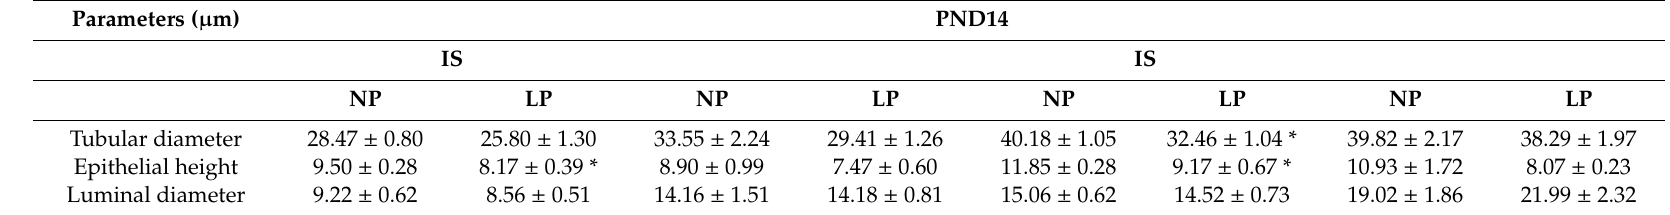
Table 3. Epididymal morphometry at